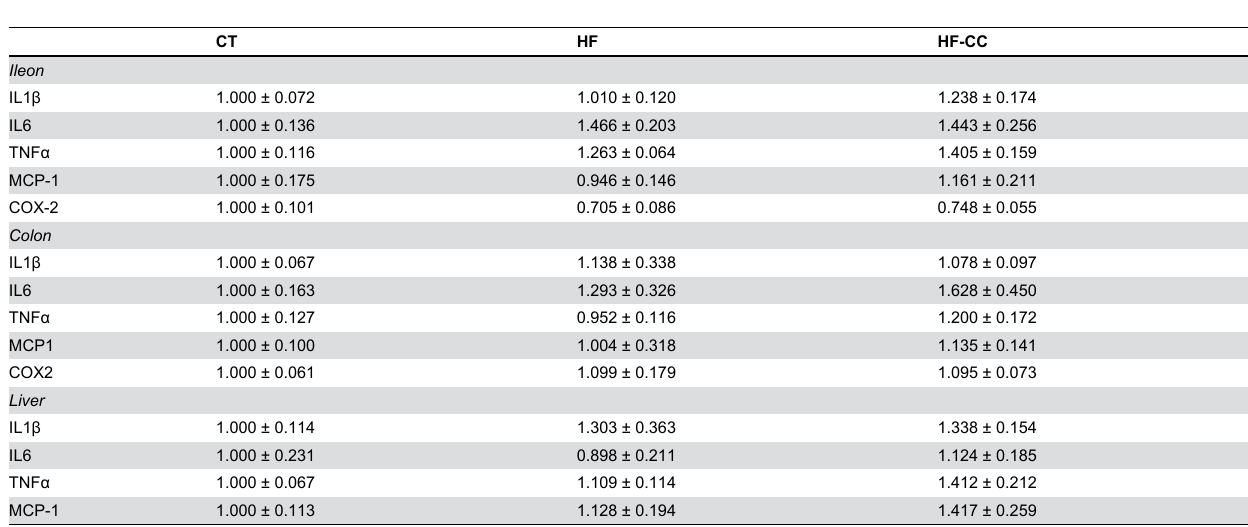
Table 3. Gene expression levels of key pro inflammatory markers in different parts of gut and in the liver.